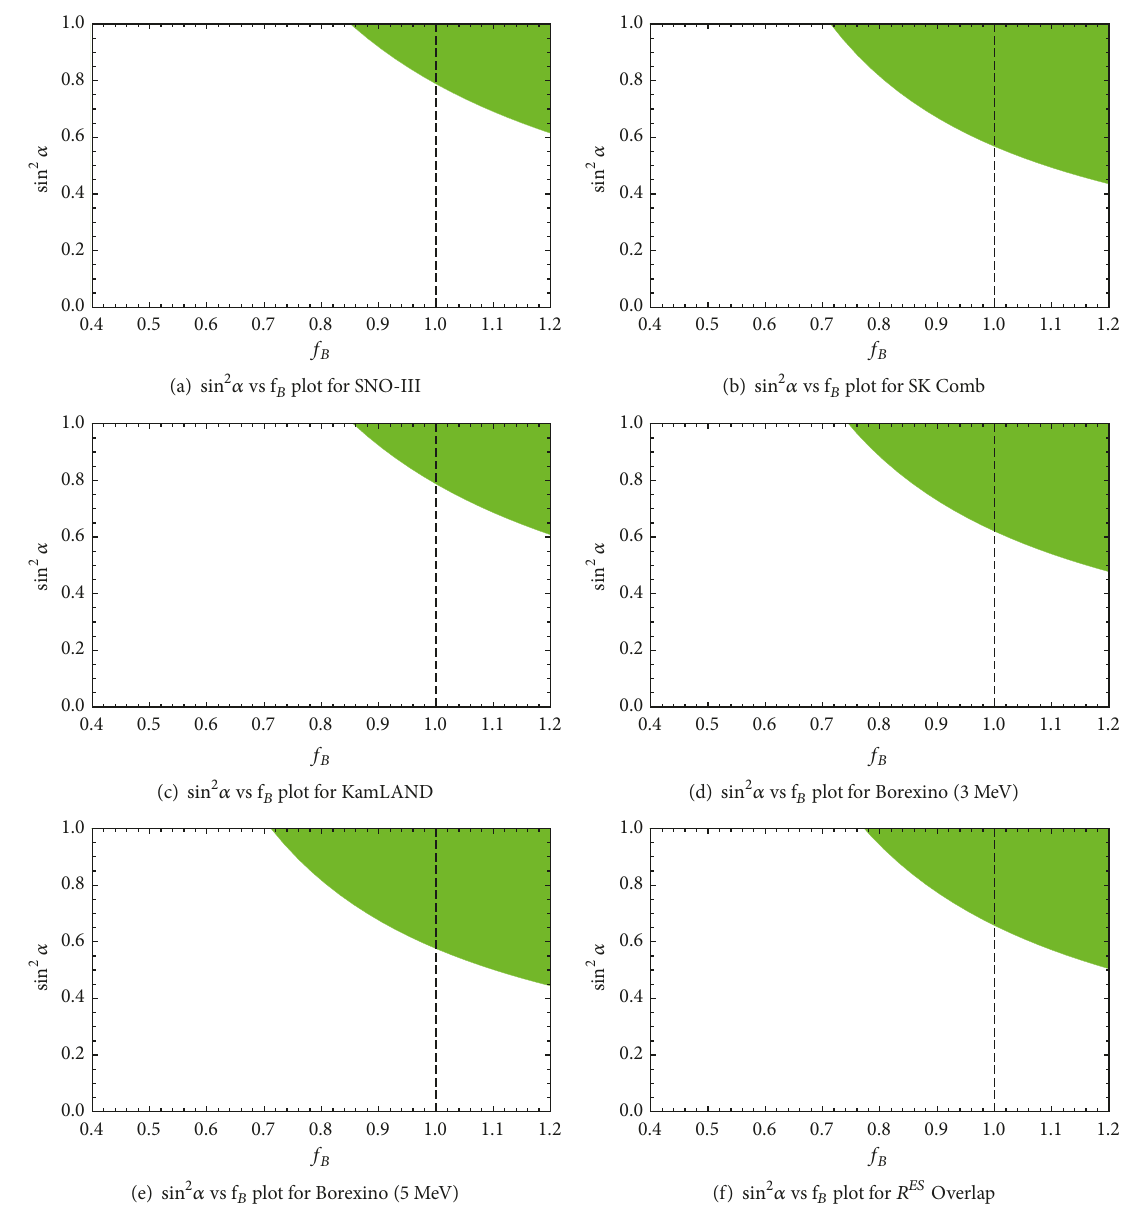
(f) sin 2 𝛼 vs f 𝐵 plot for 𝑅 𝐸𝑆 Overlap Figure 2: sin 2 𝛼 vs f 𝐵 common parameter space plots for all six sets.